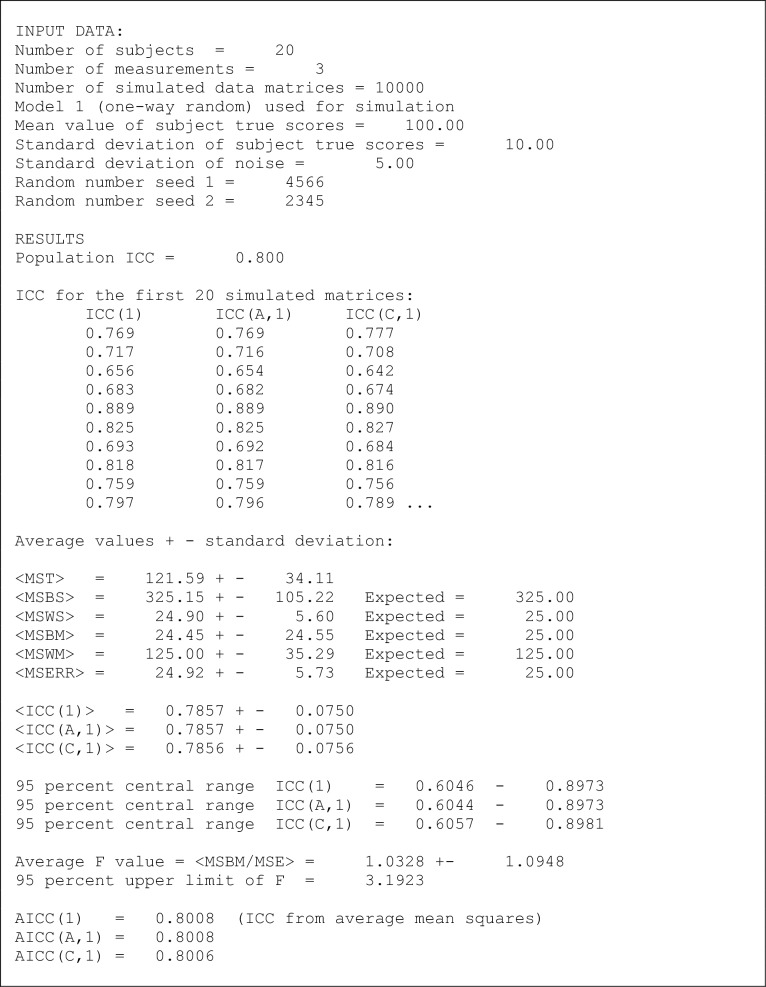
Part of the computer printout from a SIMANOVA run using Model 1.Corresponding ICC distributions are shown in Fig 4. See text for discussion.